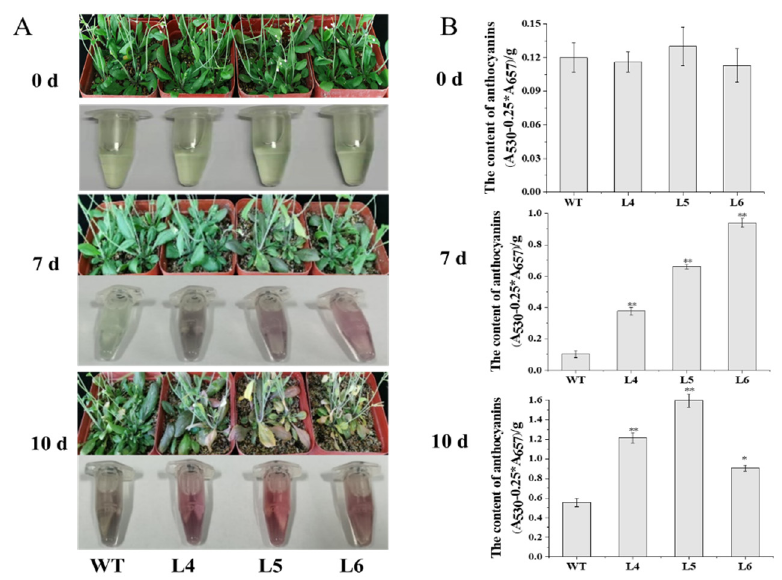
Figure 5. Phenotypes and the anthocyanins content of the transgenic Arabidopsis and wild-type seedlings under irrigation with 200 mM NaCl: ( A ) seedlings irrigated with 200 mM NaCl at 0, 7, and 10 d, respectively; ( B ) anthocyanin content in rosette leaves at 0, 7, and 10 d, respectively. **, * indicate the significant difference among L4, L5, L6, and WT at p < 0.01 and p < 0.05, respectively.